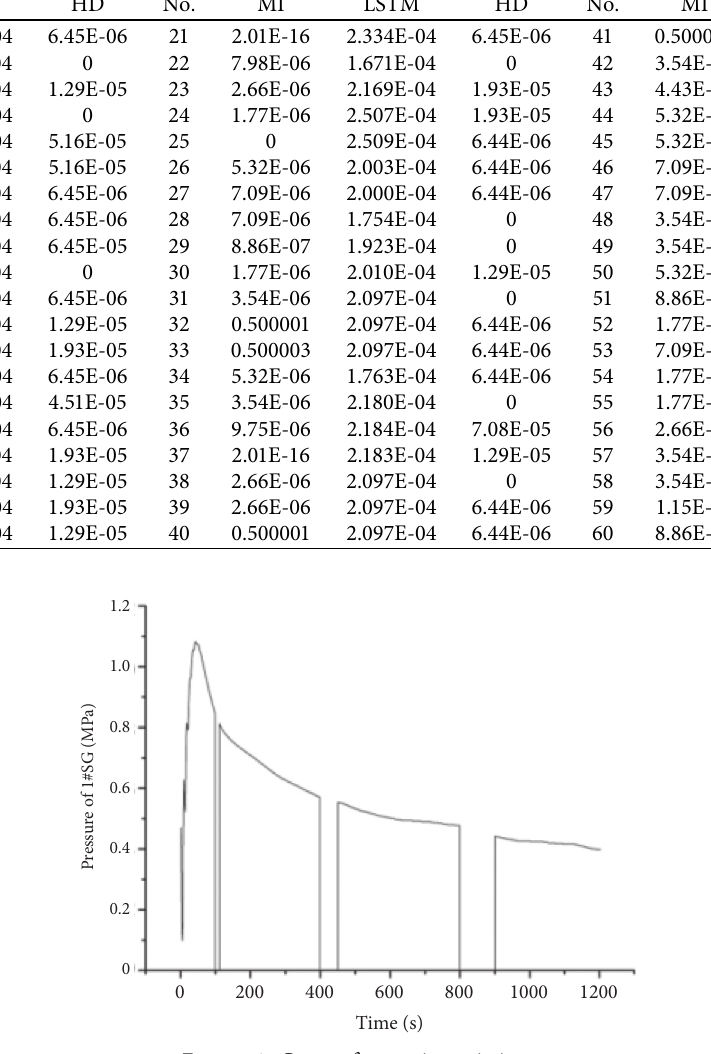
Table 3: (Attached table) Comparison of the filling error rates for missing data in pressure of PRZ. No.